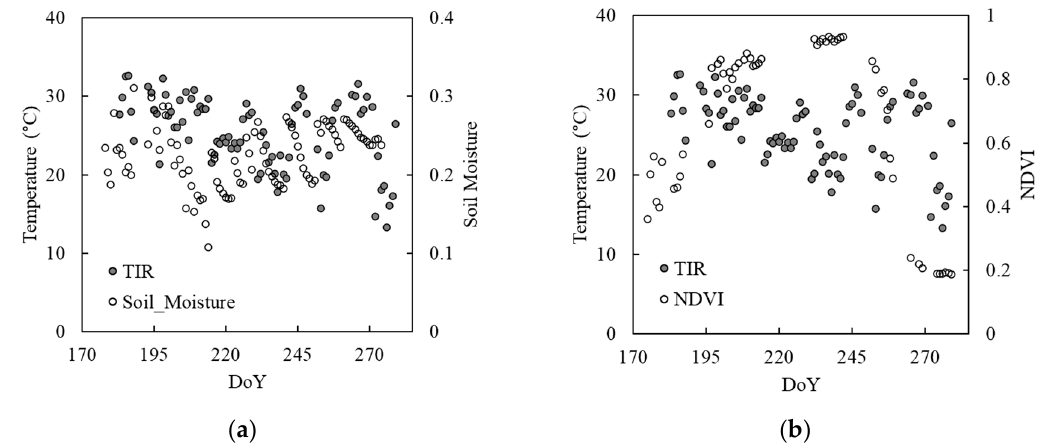
Figure 6. Seasonal trajectories of TIR temperature with ( a ) soil moisture and ( b ) NDVI of the 2015 growing season.